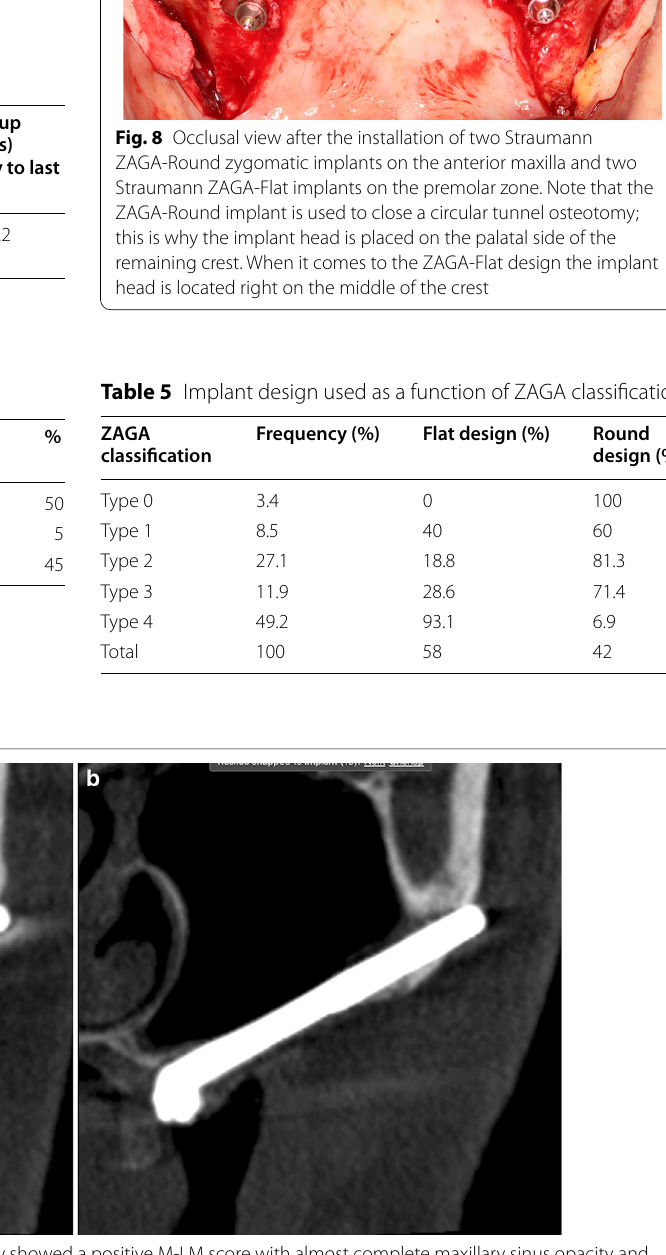
Fig. 9 a The CBCT of patient 18 taken ten days after the surgery showed a positive M‑LM score with almost complete maxillary sinus opacity and the clinical LK test was also positive. The patient was diagnosed with acute rhinosinusitis and treated with antibiotics and local corticosteroids. b The CBCT image of patient 18 taken 1 year postoperatively. Total transparency of the sinus was present; the M L‑M score was negative. (In collaboration with Drs. Guy Mclellan and Ophir